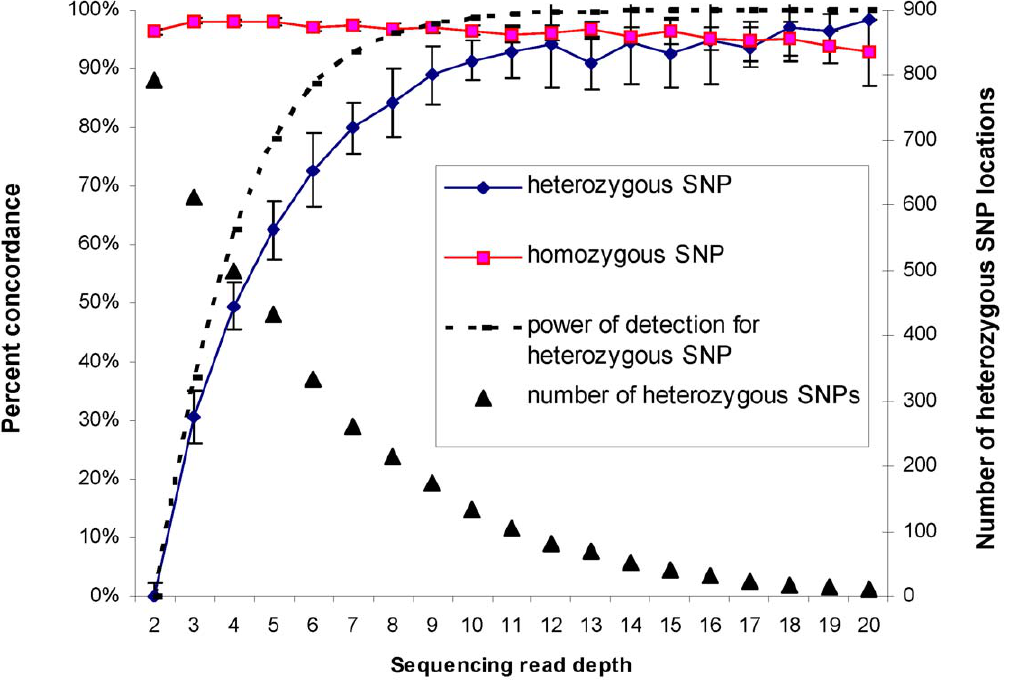
Figure 1. Sequencing depth and concordance between genotype. The graph displays a plot of average concordance of genotype calls obtained from the Affymetrix SNP Array 6.0 and from exome sequencing, as a function of sequencing read depths. Square markers indicate concordance at homozygous positions, diamond markers indicate concordance at heterozygous positions. The dashed line shows the theoretical rate of detecting heterozygous positions by sequencing (as described in Methods). Triangle markers display average number of heterozygous SNP locations per cell-line as a function of sequencing read depths (Y-axis on the right).